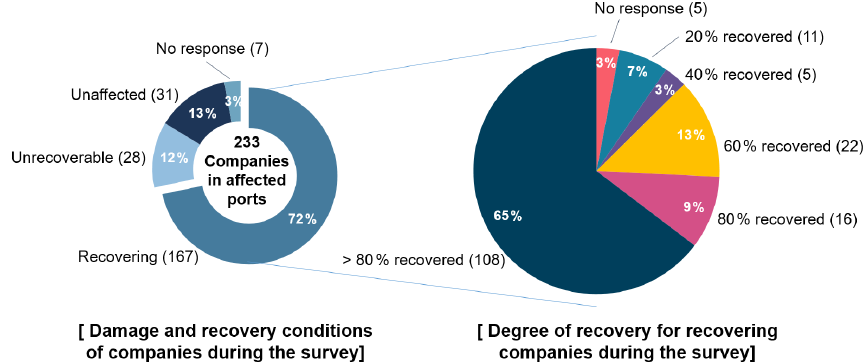
Figure 9. Damage conditions and degrees of recovery of companies in the tsunami-affected ports of Hachinohe, Kuji, Miyako, Kamaishi, Ofunato, Ishinomaki, Sendai-Shiogama, Soma and Onahama. A total of 65% of the recovering companies were almost close to full recovery ( > 80%) at the time of the survey. Adapted and translated from MLIT (2011).